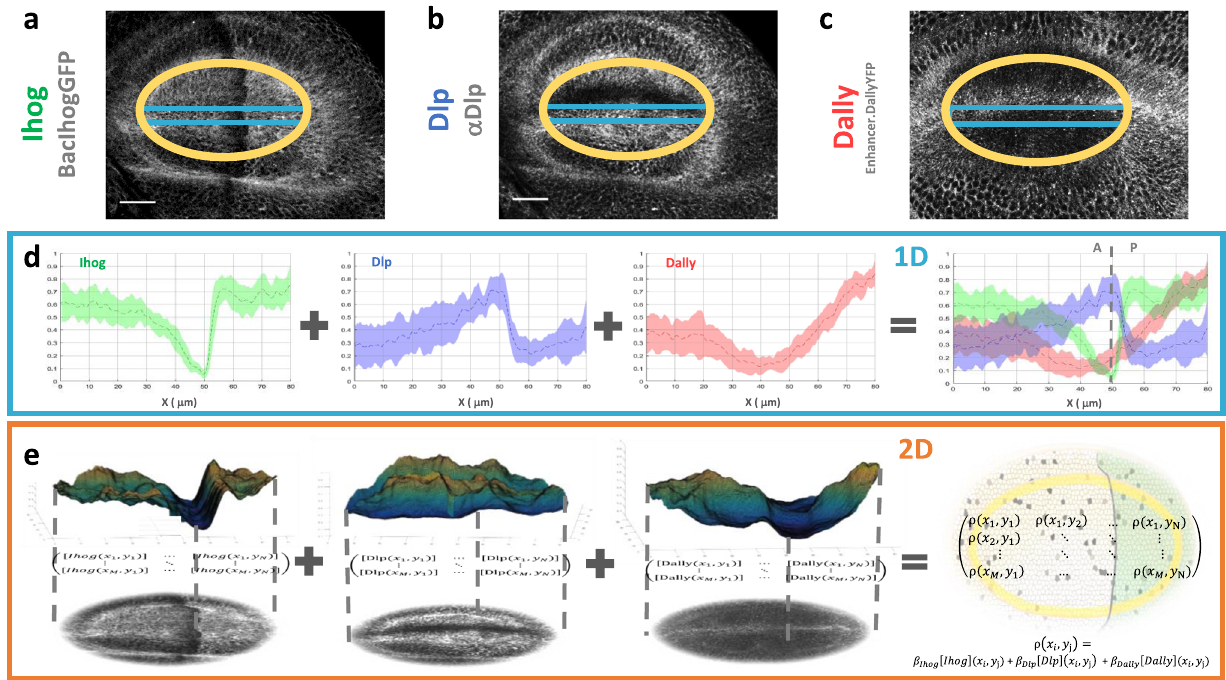
Fig. 6 | Wild typeIhog, Dallyand Dlp spatialdistributions atthe basalplaneof wingimaginaldiscs.a WildtypeIhogbasaldistributioninaBac.IhogGFPwingdisc. b Wild type Dlpbasaldistribution obtained by immunohistochemistry. c Wild type Dally basal distribution in a Dally.trap.YFP wing disc. d Characterization of Ihog (green),Dlp(blue)andDally(red)pro fi lesatthebasalplaneofimaginalwingdiscs. Dotted lines represent the average pro fi le and shaded area and their experimental